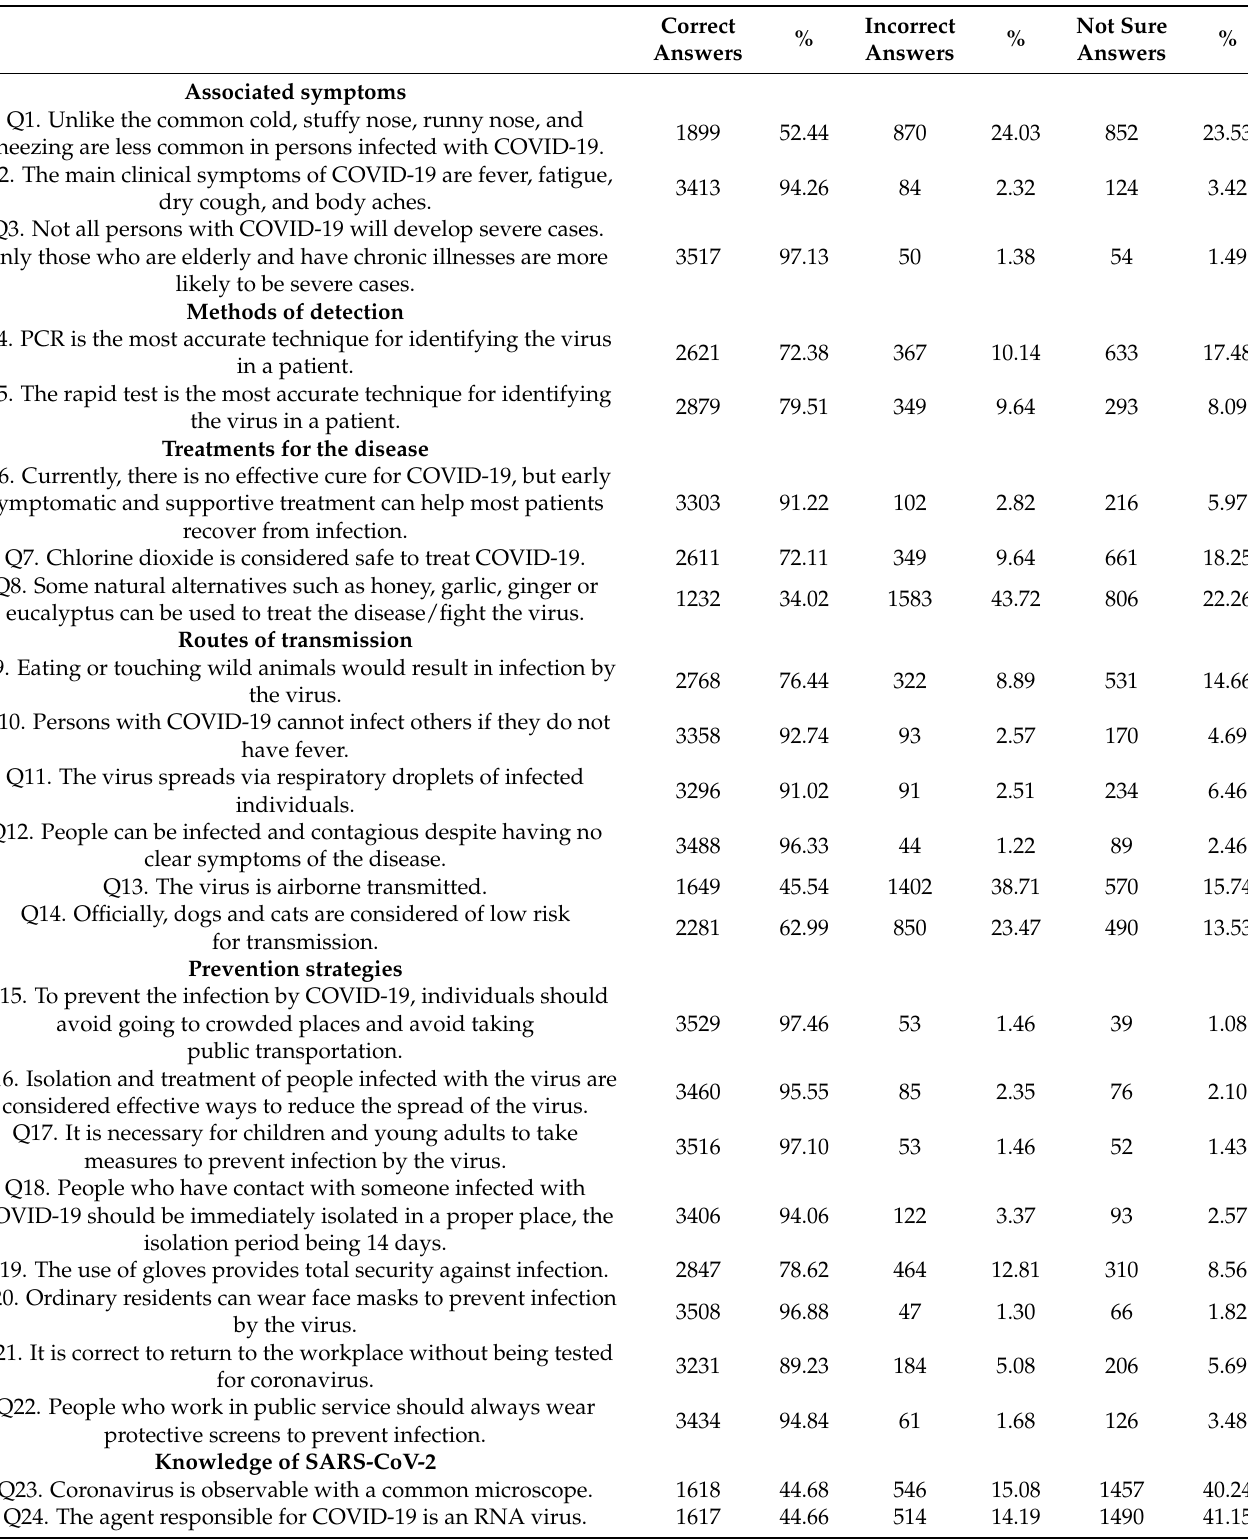
Table 4. True/False questions used to measure COVID-19 knowledge among undergraduates.